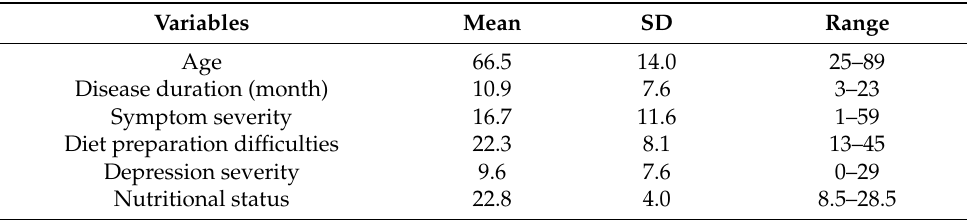
Table 1. Participants’ characteristics and descriptive data of study variables (N =